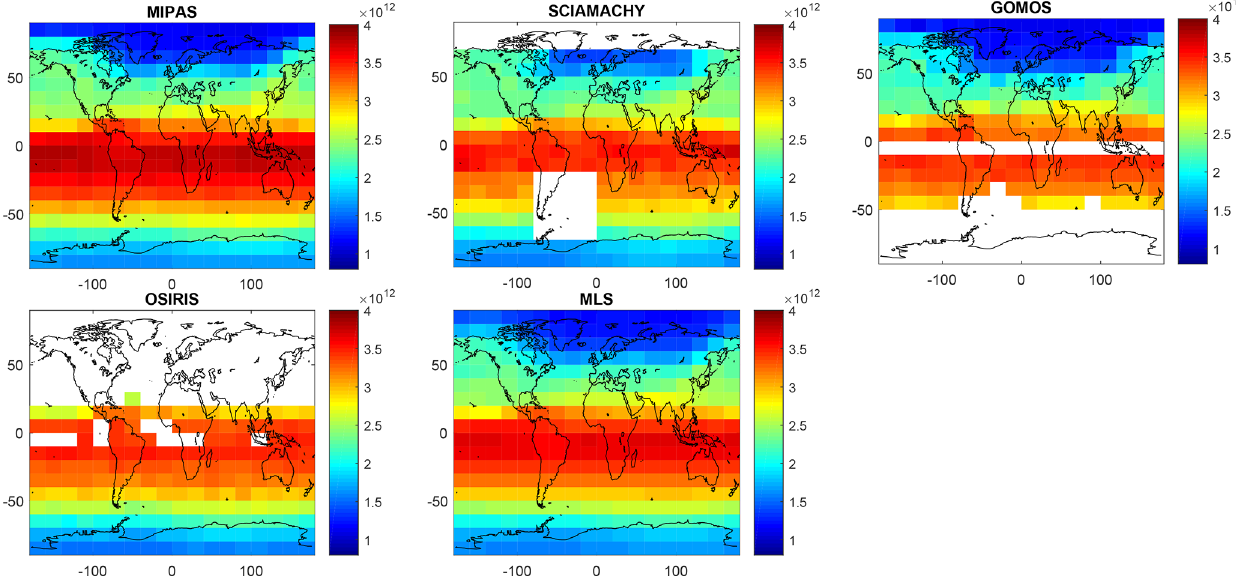
Figure 1. Examples of gridded monthly mean ozone number density (cm − 3 ) at 30km for individual satellite instruments in January 2008.